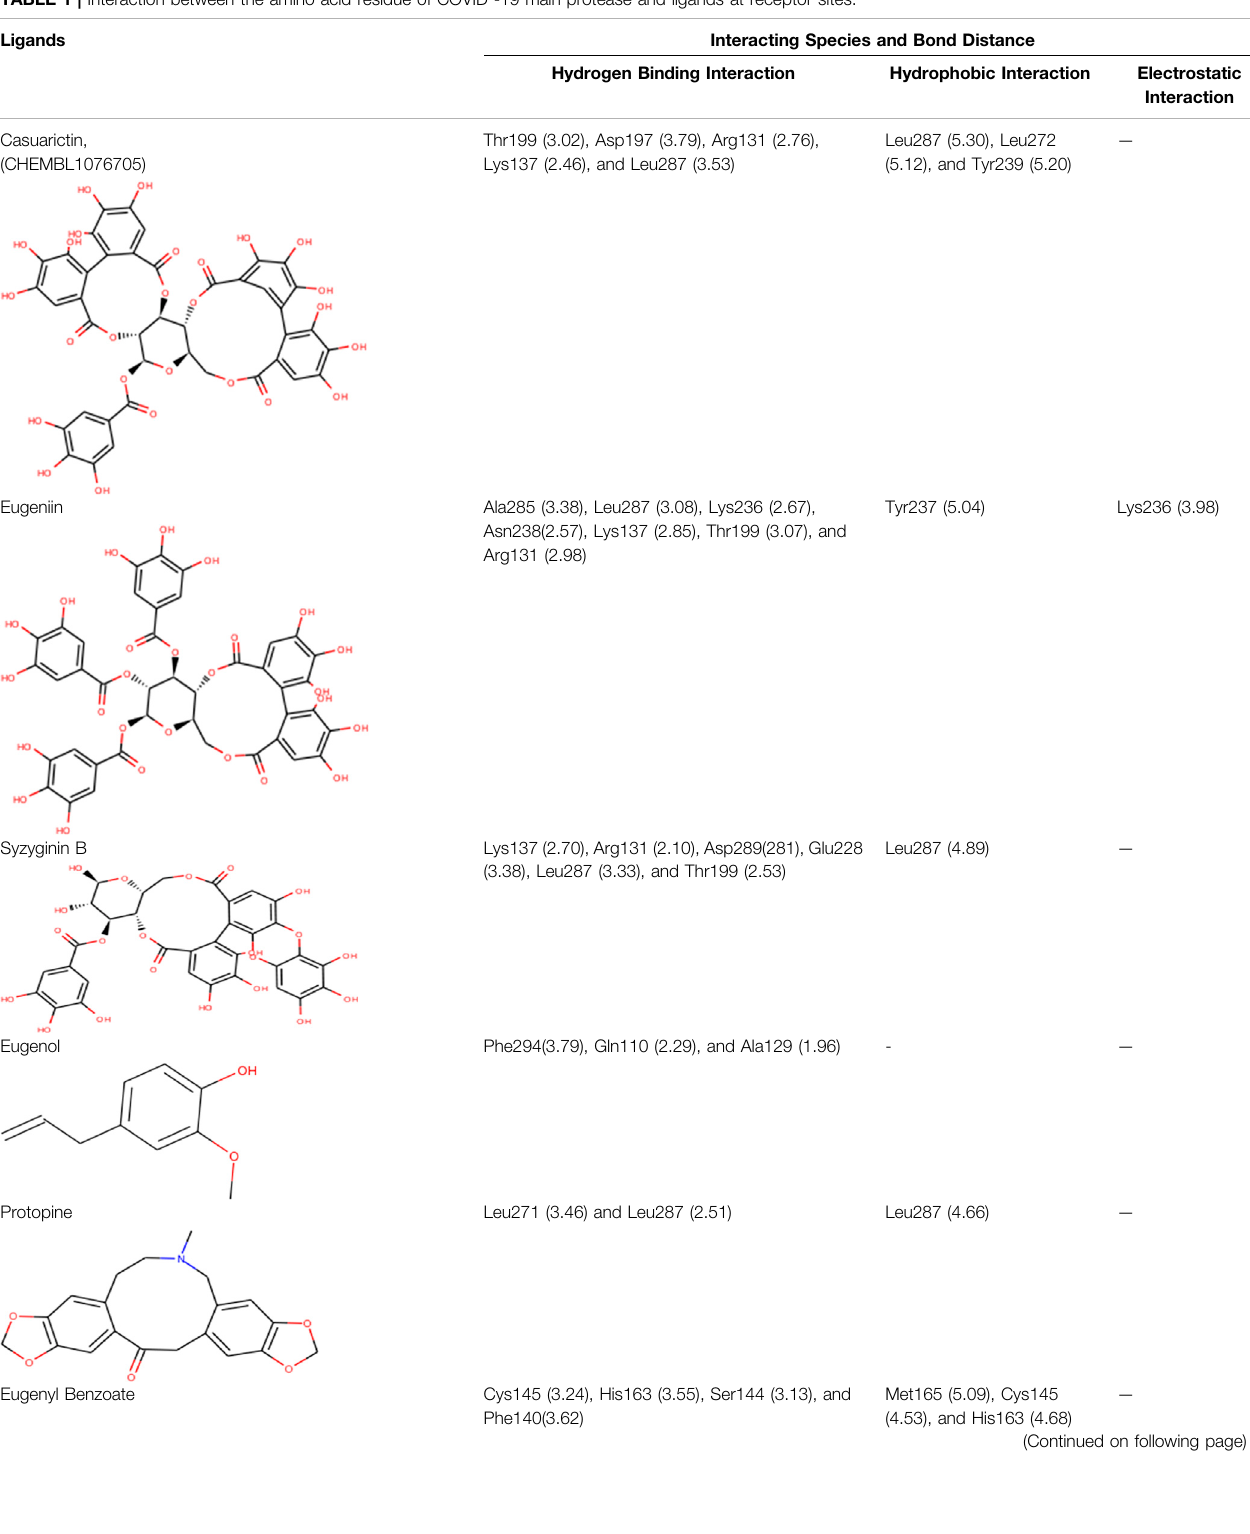
TABLE 1 | Interaction between the amino acid residue of COVID -19 main protease and ligands at receptor